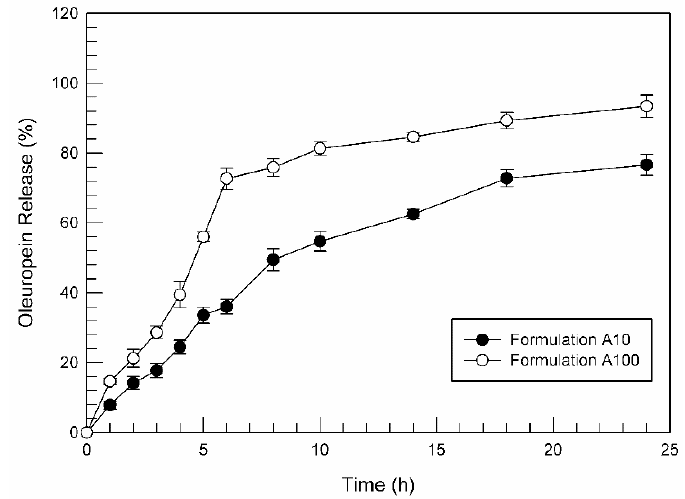
Figure 9. Release profile of oleuropein-loaded ufasomes. Values represent the mean of three different experiments ± standard deviation. If bars are not visible, they are within the symbols.